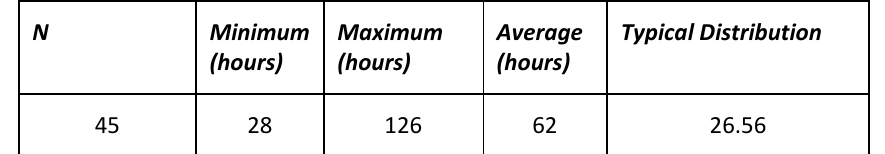
Table 9. Statistical Distribution of student